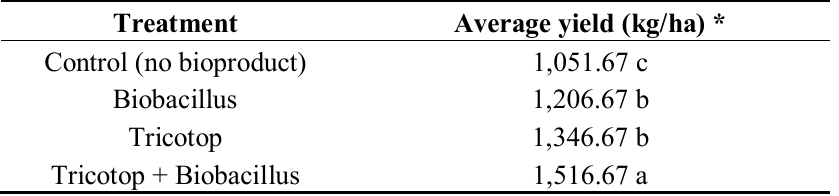
* Different letters mean statistical differences between treatments of p = 0.05.